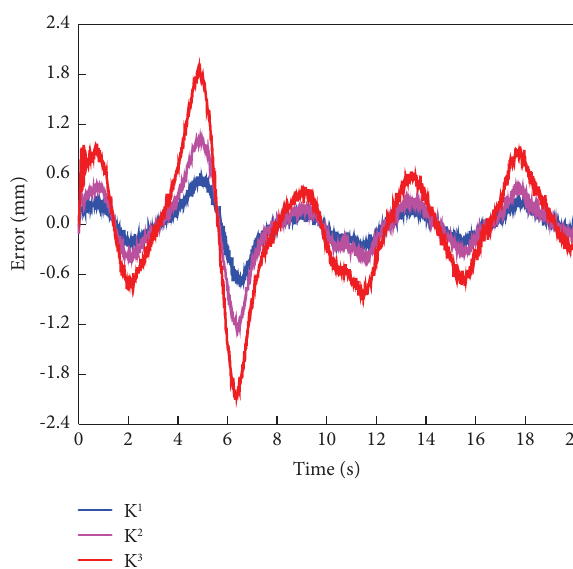
Figure 7: Comparison errors for diferent parameters of the proposed